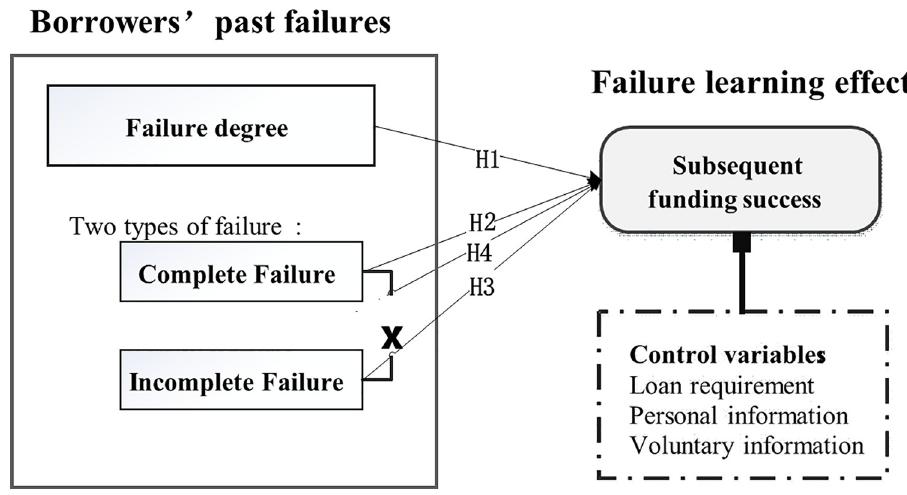
Fig 1. Illustration of the framework in this